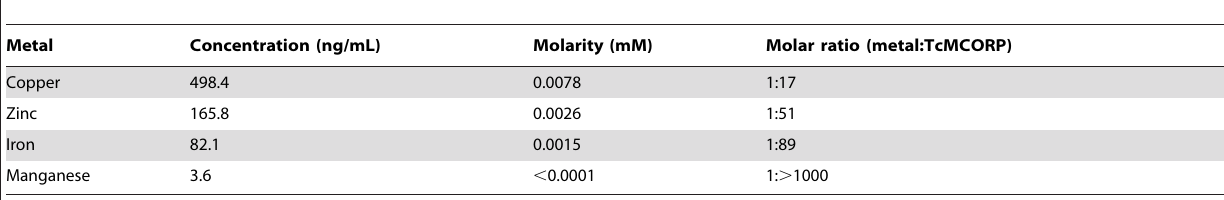
Table 1. ICP-MS analysis of recombinant